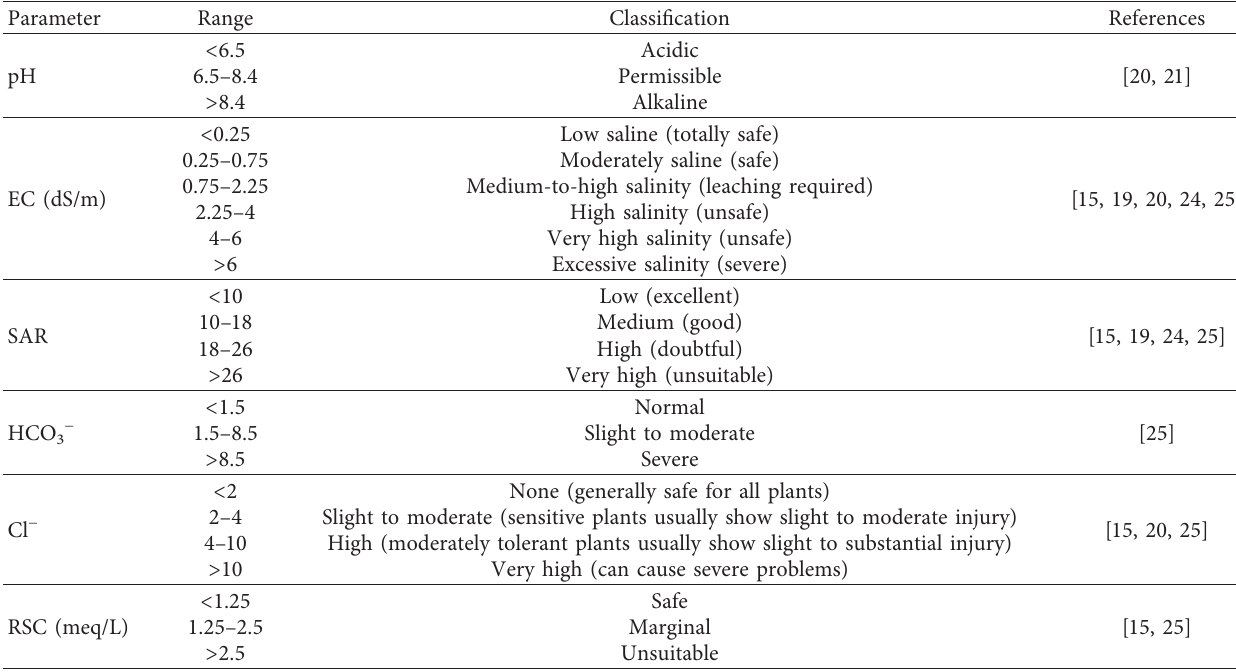
Table 9: Classification of irrigation water